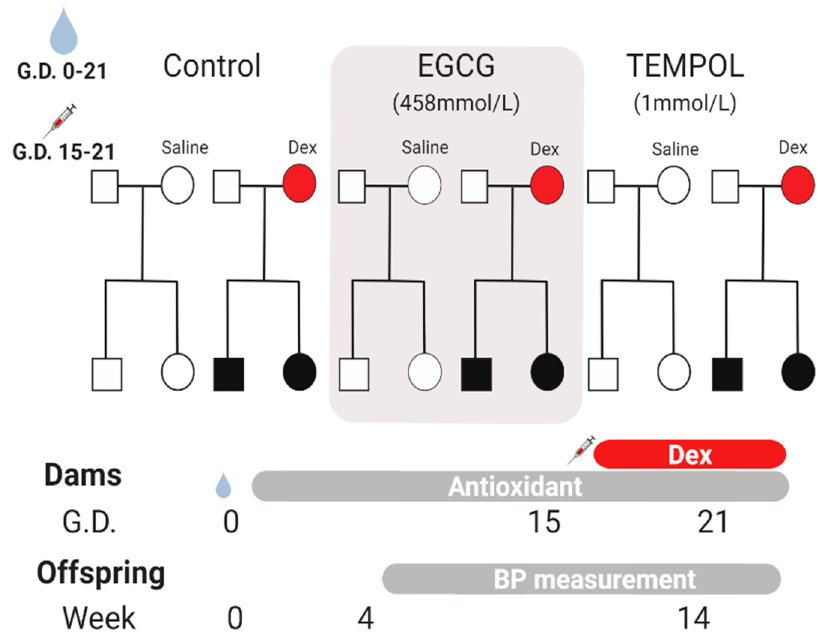
Figure 1. Overview of maternal antioxidant administration and dexamethasone (Dex)-mediated fetal programming. Pregnant WKY dams received antioxidant supplementation or vehicle throughout gestation days 0–21. Fetal programming was achieved using S.C. injection throughout the third trimester, 100 ug/kg days 15–21. Offspring subjected to Dex in-utero are depicted in black. Blood pressure measurements were determined based on a weekly average throughout development from weeks 4–14. Euthanasia occurred at the beginning of week 15, and adrenal glands were harvested for gene expression analysis.